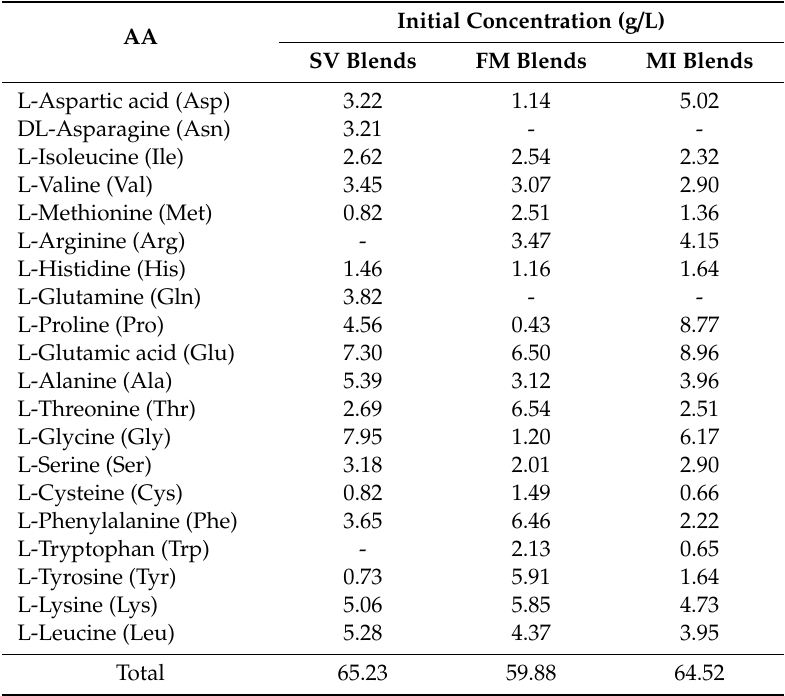
Table 1. Compositional profiles of amino acid (AA) blends used for lipid